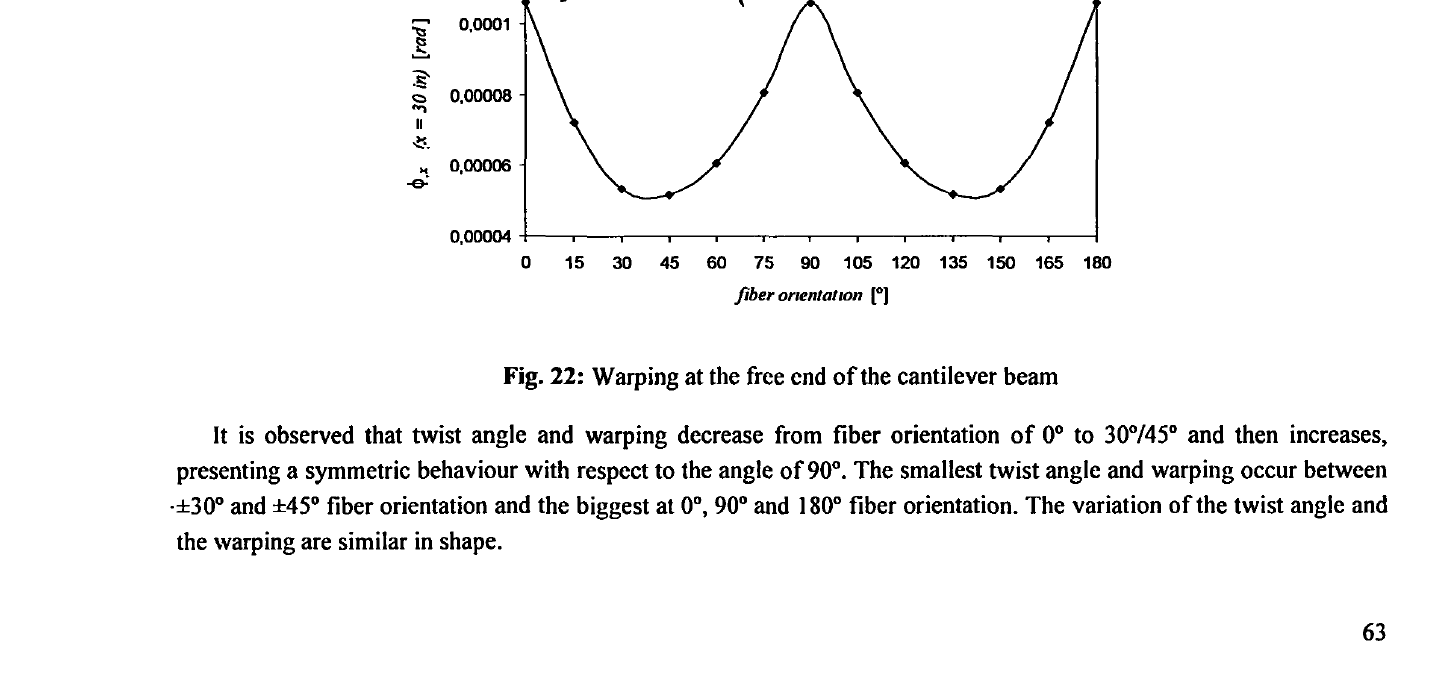
Fig. 21: Twist angle at the free end of the cantilever beam